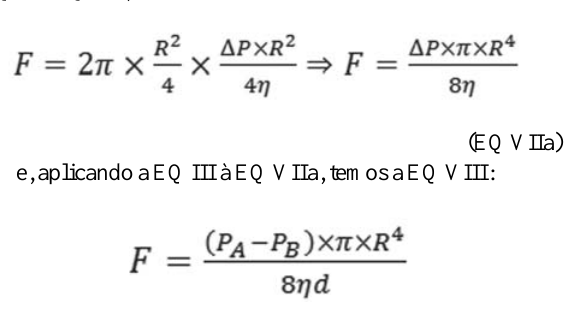
EQ IV: Vr = velocidade do líquido medida à distância ‘r’ do centro do tubo; Vmáx = velocidade máxima do líquido no tubo; R = raio do tubo; r = distância até o centro do tubo. Assim, quando r = R, Vr = 0 e quando r = 0, Vr = Vmax. Como Vr cresce em função do quadrado de r, o perfil de velocidade no interior de um condutor tubular é parabólico, como demonstra a Figura